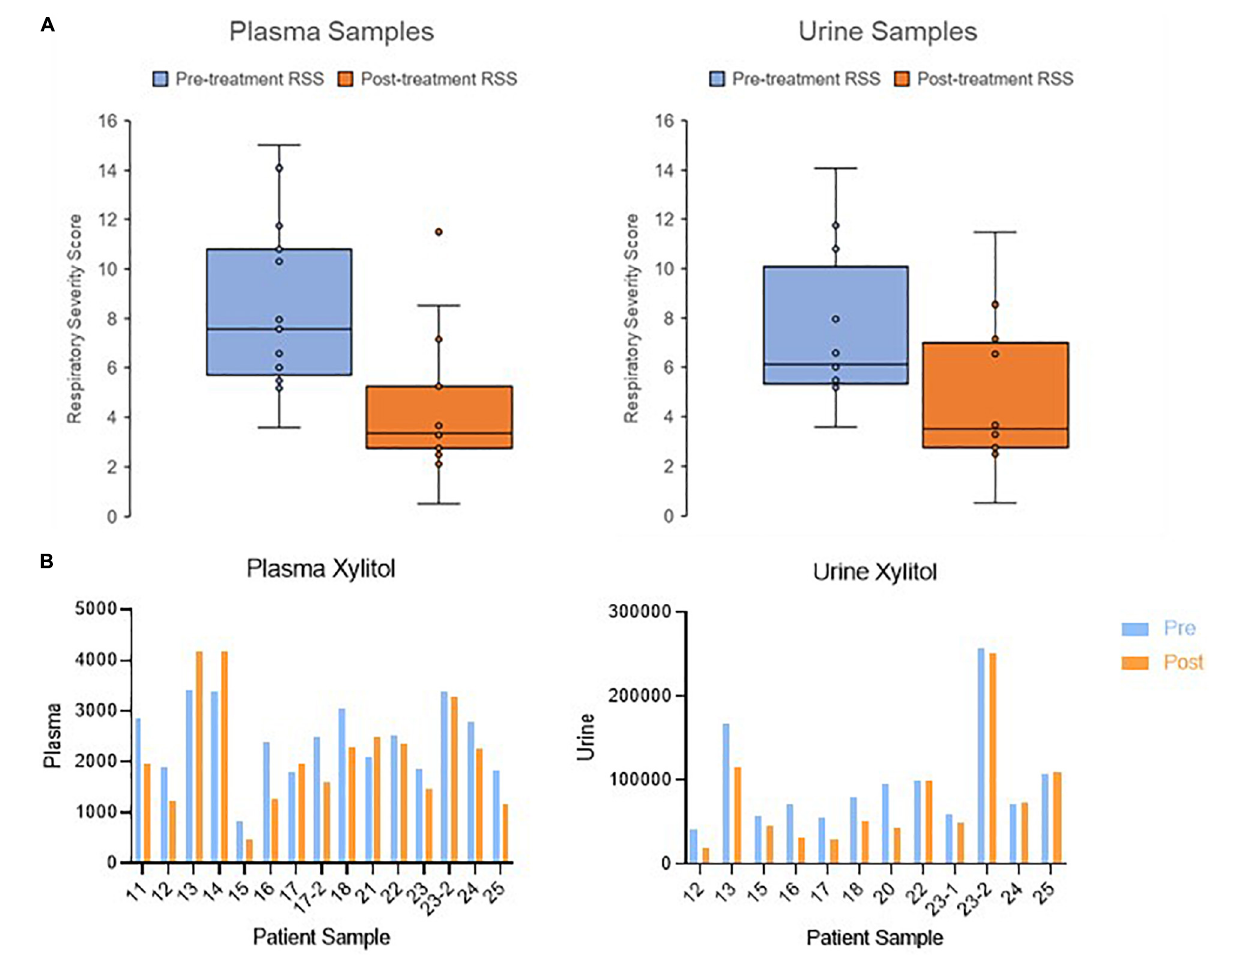
FIGURE 1 | Change in clinical outcome and metabolite abundance from pretreatment to post-treatment. (A) Boxplots showing the change in respiratory severity score in patients with collected plasma and urine samples. (B) Bar graph showing the change in xylitol as an example metabolite. Metabolite abundance is displayed with arbitrary units of